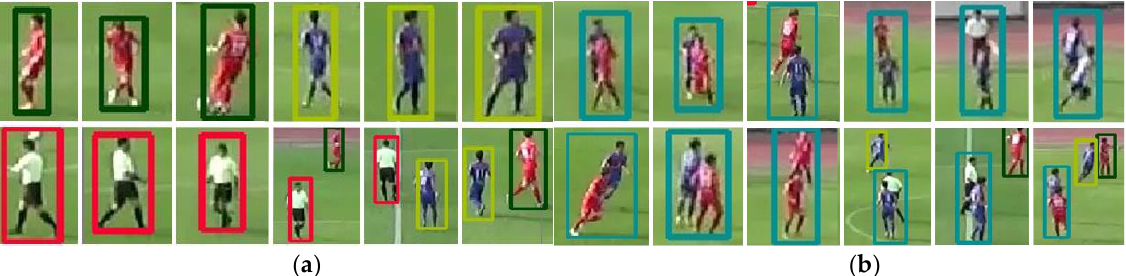
Figure 6. Object bounding box marking samples of training data using Yolo Mark: ( a ) Samples of Class A (Dark Green box), Class B (Light Green box), and Class C (Red box) marking; ( b ) Samples of Class D (Sky Blue box) marking.